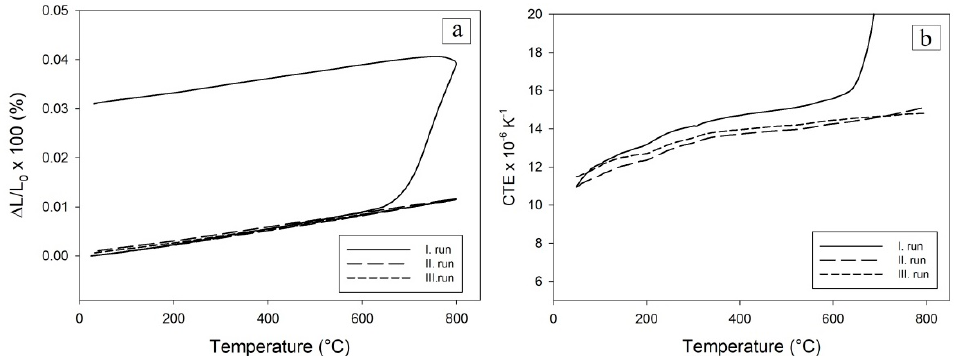
Figure 11. Relative elongation ( a ) and coefficient of the thermal expansion ( b ) were observed for the green compact oxidized to 600 °C and subsequently thermocycling to 800 °C in the Ar atmos-